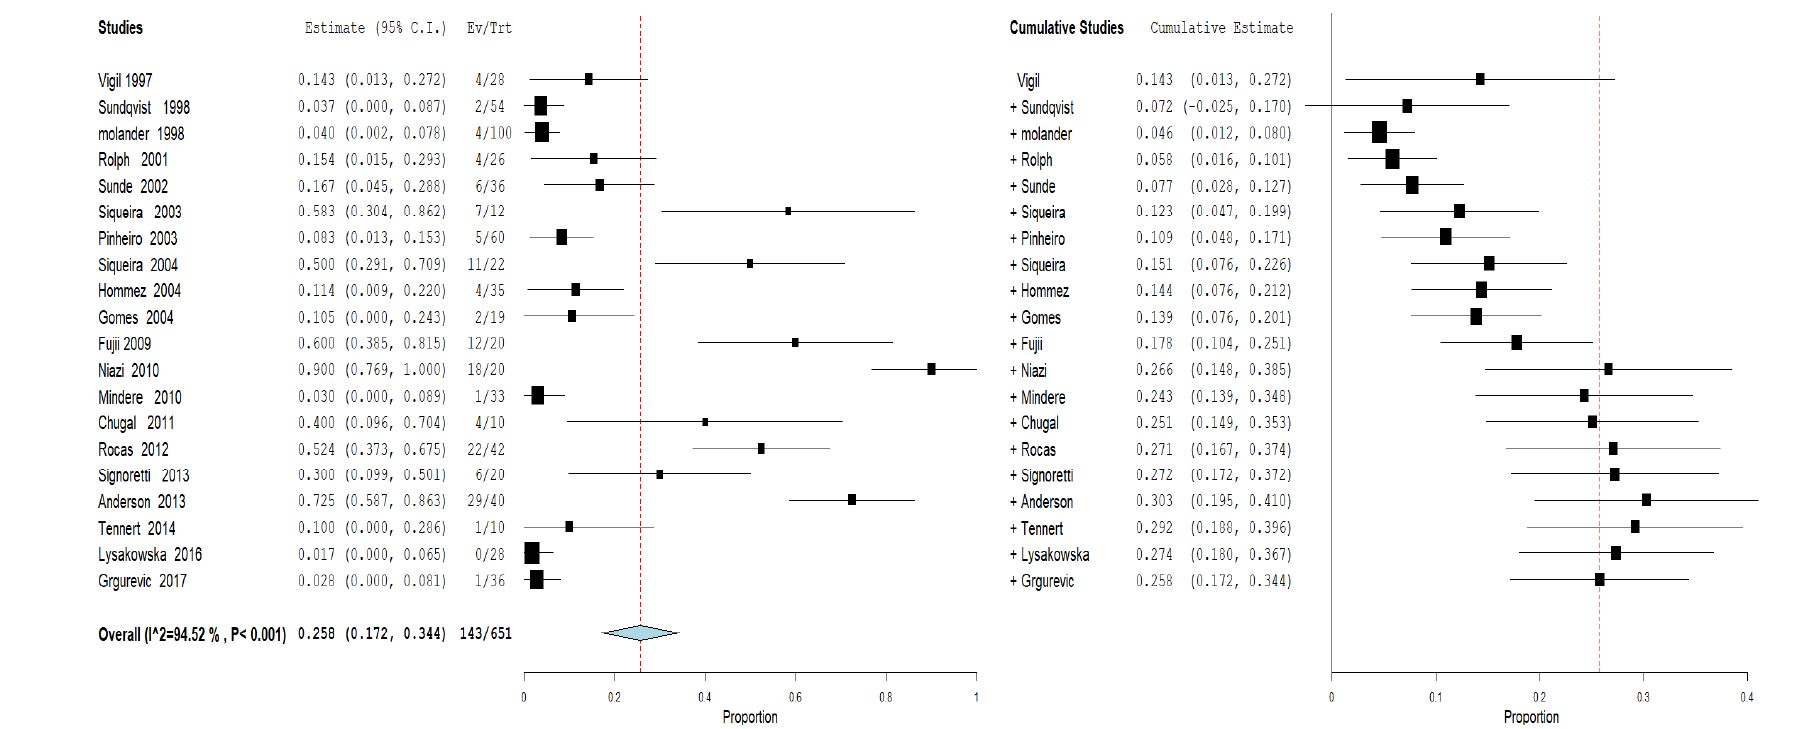
Figure 5. Forest plot of the random effects model of the meta-analysis cumulative of the primary outcome subgroup B.